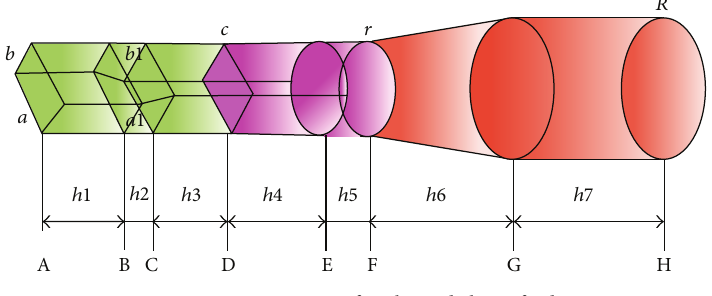
Figure 5: Geometry of multimode horn feed. Table 1: Geometry parameters lists of the multimode feed horn.